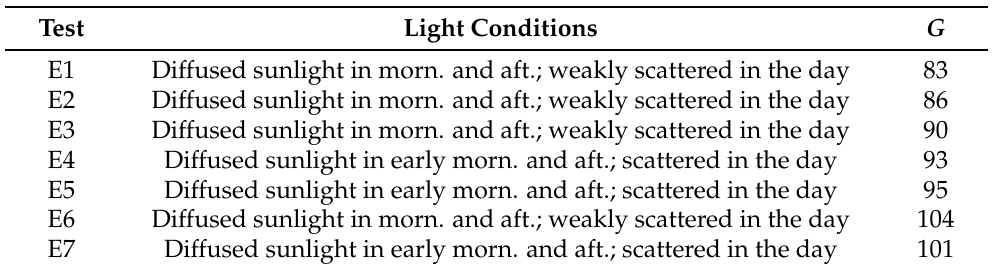
Table 2. Light conditions during each experimental test. Abbreviations “morn.” and “aft.” stand for morning and afternoon, respectively. The index G quantifies the average intensity of gray-scale images captured during the